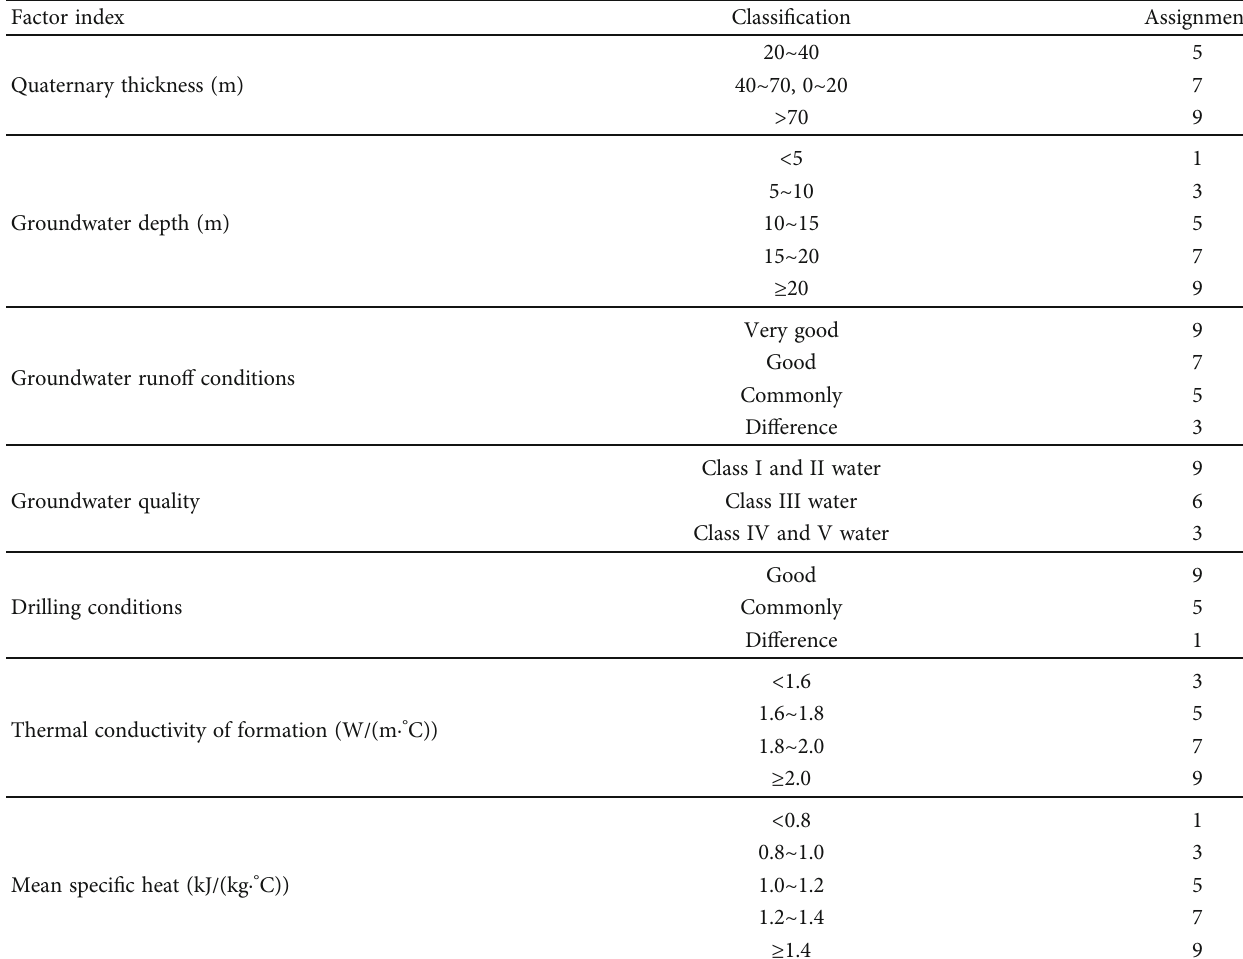
Table 5: Evaluation table for suitability factors of the ground source heat pump.